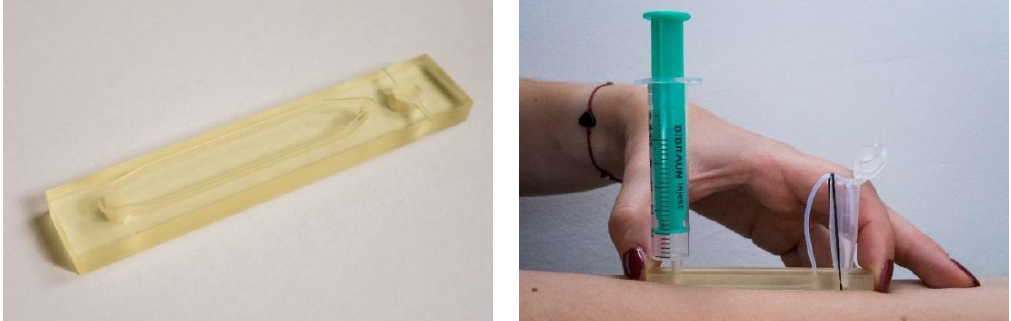
Figure 2. A photograph of the 3D printed sampling device (upside down) and a photograph of the fully assembled device with the syringe and the collection vial, placed on the subject’s forearm, ready for sampling.